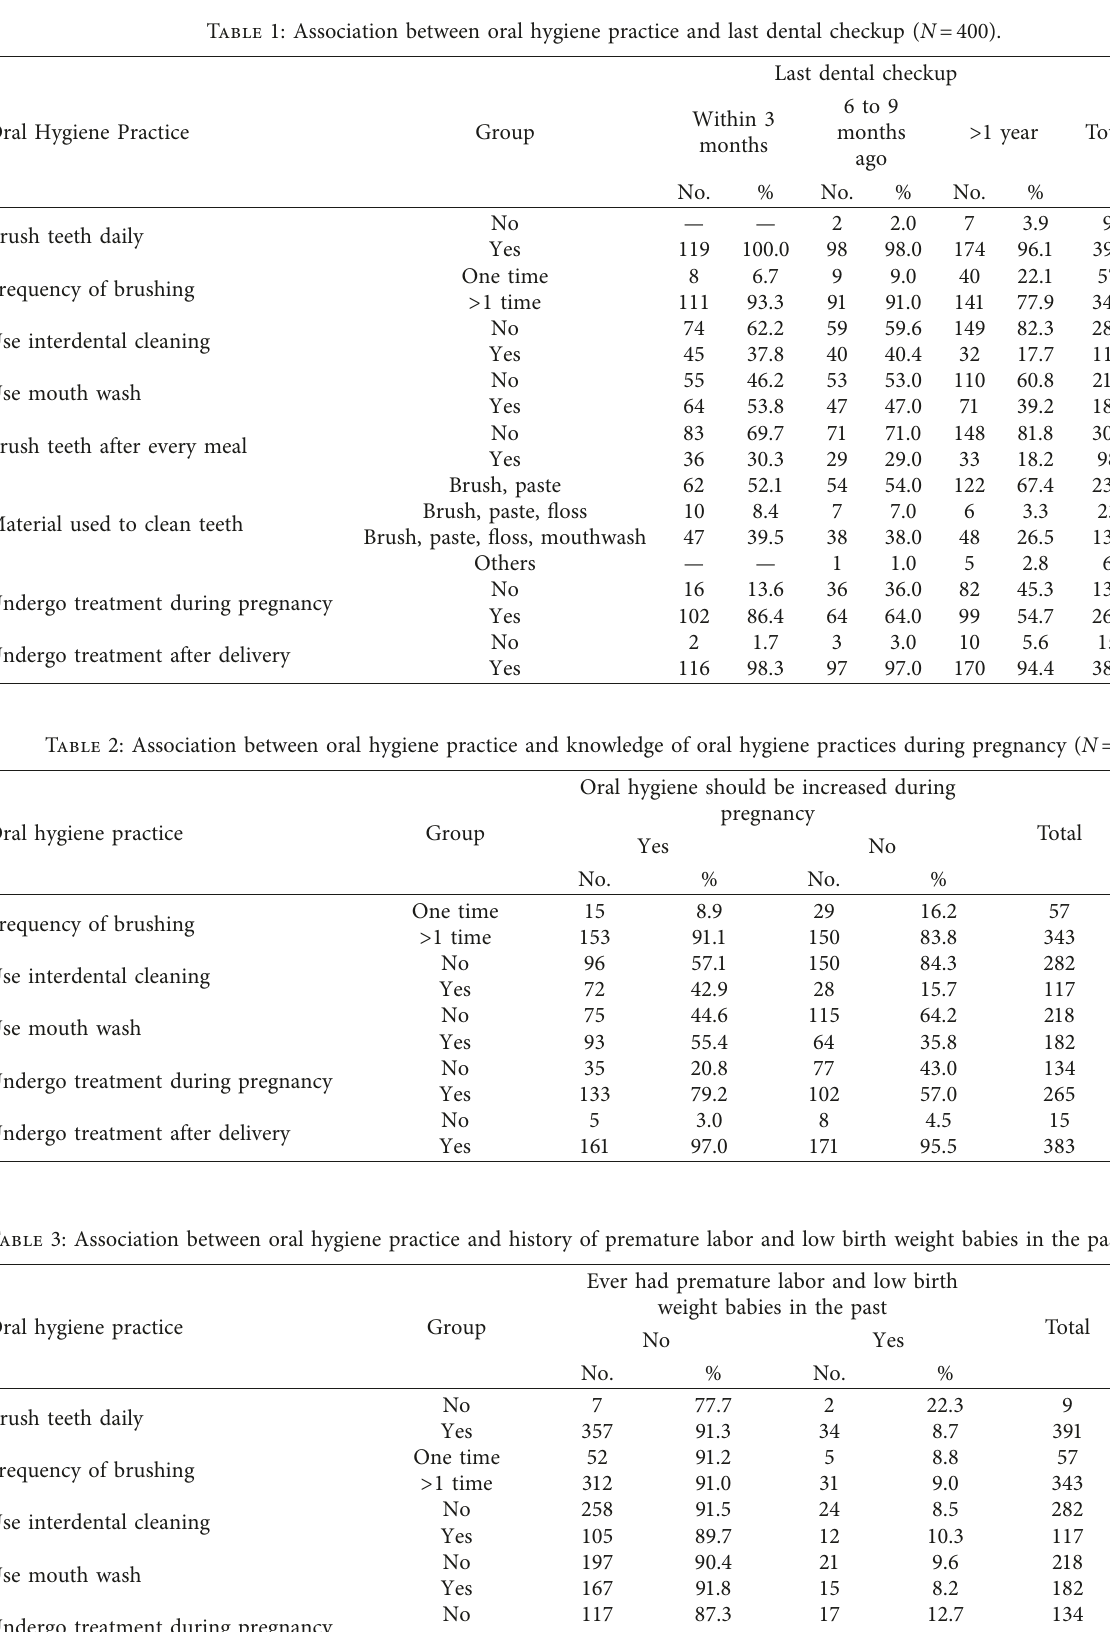
Table 1: Association between oral hygiene practice and last dental checkup ( N � 400).